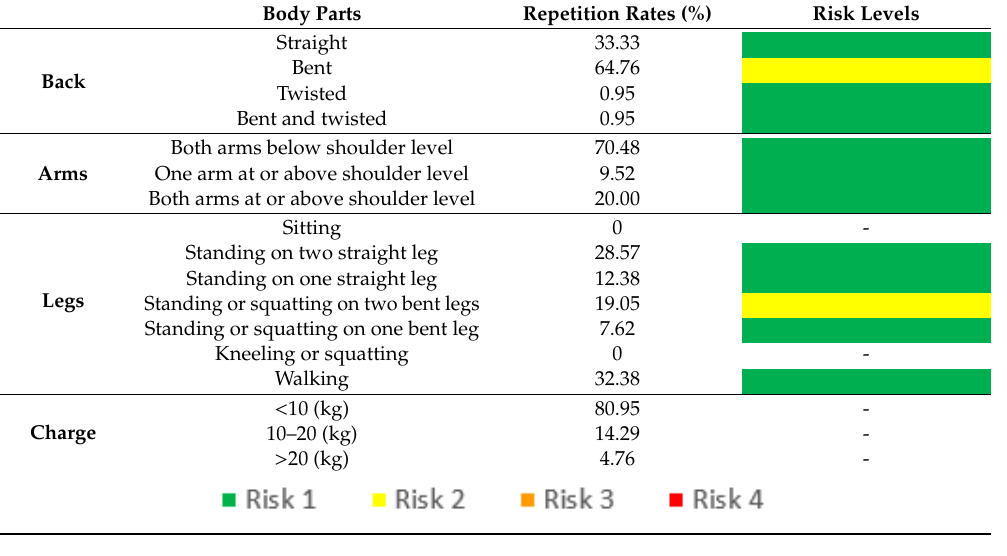
Table 5. Risks in each